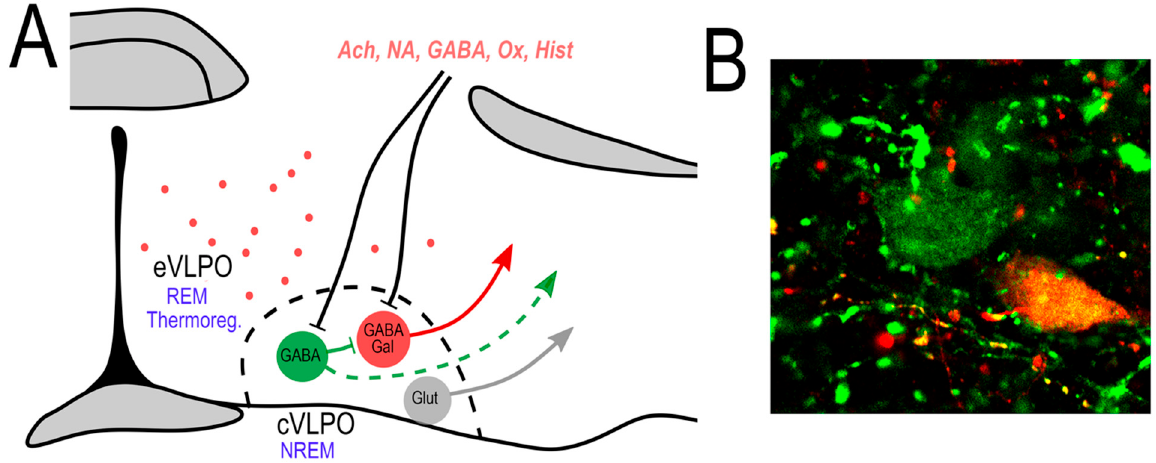
Figure 1. Cellular anatomy of the VLPO. ( A ) The VLPO core (cVLPO) contains several distinct neuronal populations including: (1) GABAergic neurons that express galanin (VLPO Gal ), which are NREM sleep-promoting neurons; (2) GABAergic neurons that do not express galanin (VLPO GABA ), which possibly suppress the activity of the VLPO Gal neurons; and (3) glutamatergic neurons that presumptively promote arousal. There is also a subgroup of galanin neurons scattered in a region dorsal and medial to the core of VLPO, in the so-called extended VLPO (eVLPO). These neurons are involved in REM sleep and possibly in thermoregulation. Afferents to the cVLPO regulate the VLPO Gal sleep-promoting neurons directly and/or indirectly through local VLPO GABA neurons. These VLPO GABA neurons might also project outside of the VLPO core. ( B ) Confocal image showing VLPO Gal neurons (double labeled) and VLPO GABA neurons (in green). In situ hybridization for Vgat in green and galanin in red.